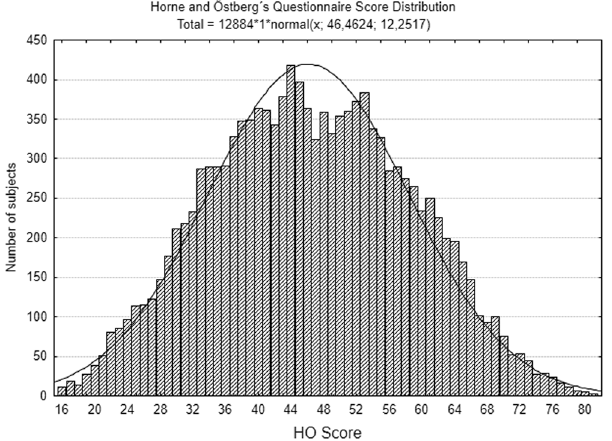
Figure 1. Distribution of HO scores for the entire sample of data. Each bar for each score represents the frequency (number of subjects). Low scores represent evening types and high scores morning